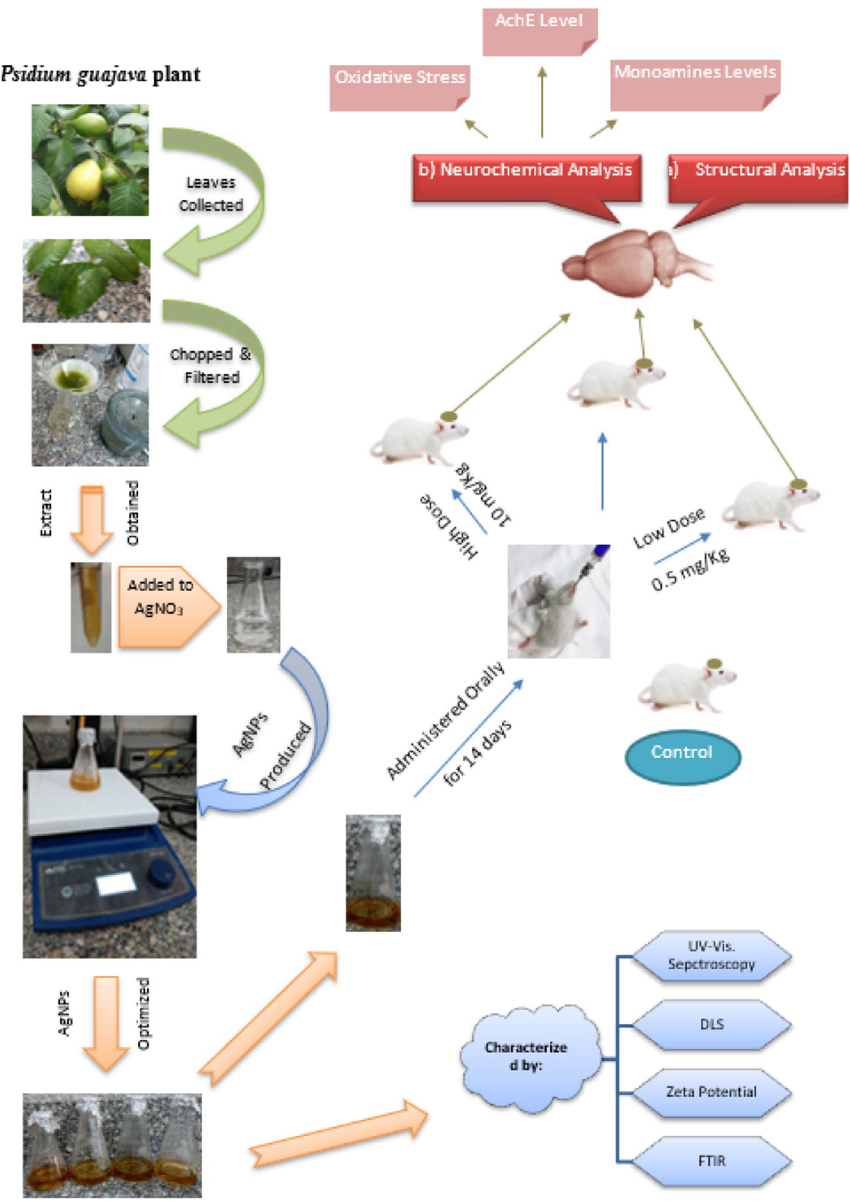
Figure 1. Graphical representation of the experimental procedures and study design and evaluation